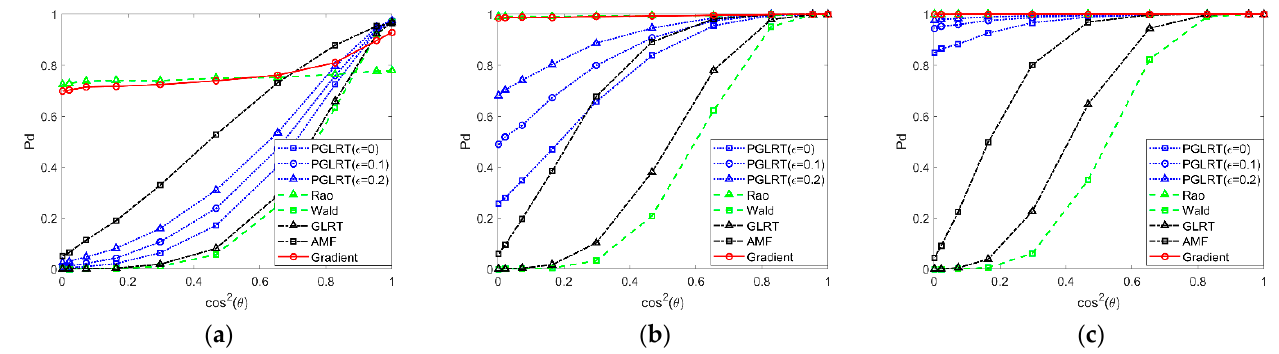
P of the detectors as a function of 2 cos θ and d